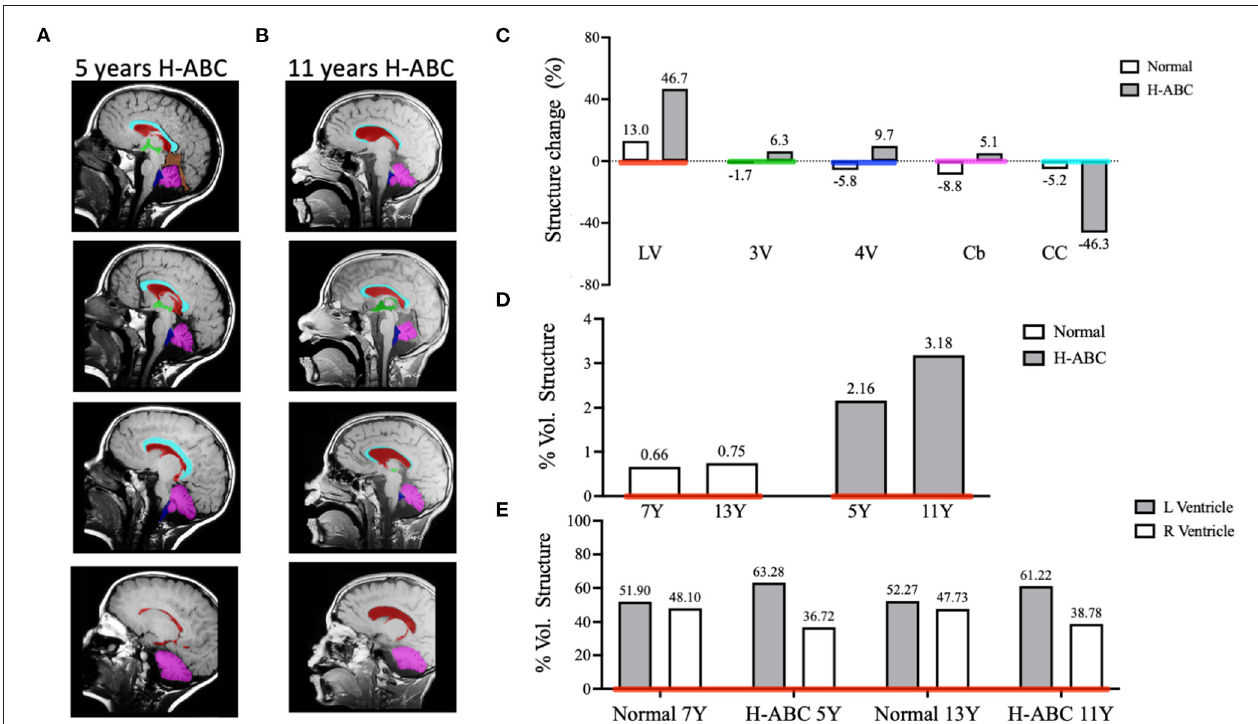
FIGURE 2 | Comparative analysis of brain structure volumes in the H-ABC patient and normal children in a period of 6 years. Representative images of T1-weighted sagittal sections illustrating individual masks in the brain structures of interest (A,B) . Lateral ventricles (LV) in red, third ventricle (3V) in green, fourth ventricle (4V) in blue, cerebellum (Cb) in magenta, and corpus callosum (CC) in cyan. Change of volume structures from normal children and the H-ABC patient (C) . The percentage of volume of the lateral ventricles related to the cranial volume (D) . The percentage of left and right lateral ventricles related to total lateral ventricle volume (E) . Numbers at the top of each bar indicate the value of represented